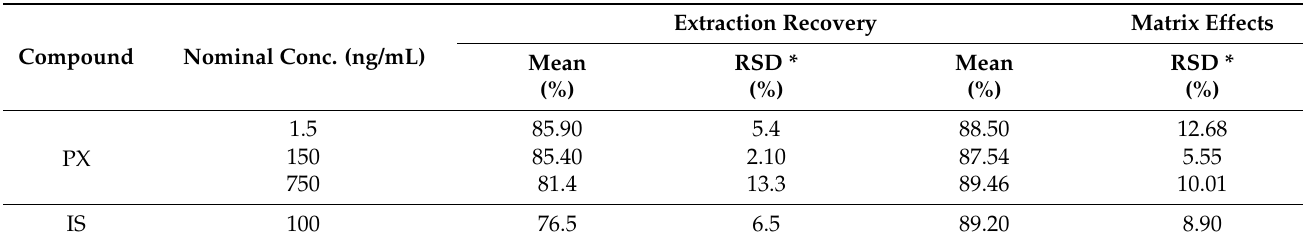
Table 3. Recovery % and matrix effects of PX and IS in